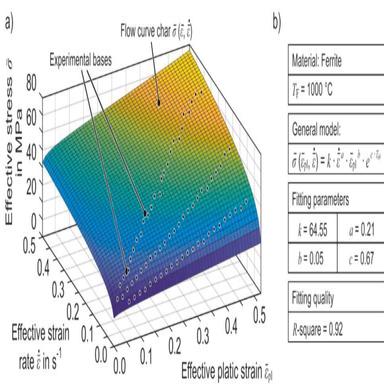
a) Fitted flow curves σ(ε, ˙ ε) using the simplified Hensel-Spittel-model based on the data from the hot-tube-bulge test for the ferritic steel and b) used model with the corresponding fitting parameters.